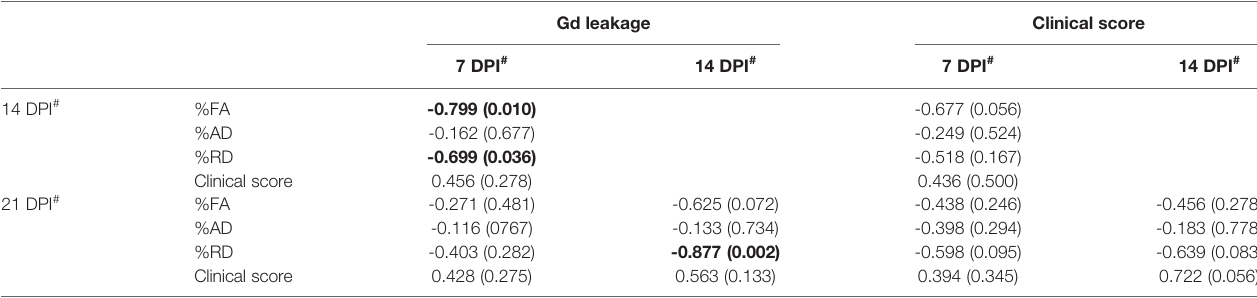
TABLE 2 | Correlation analysis between Gd leakage and MRI parameters in the control group. Gd leakage Clinical